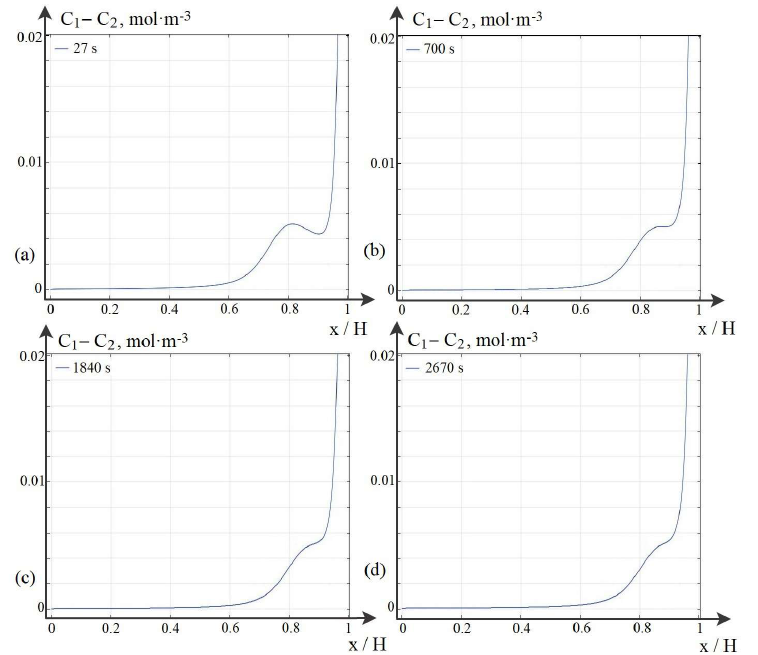
Figure 2. Dependence of the local maximum on the exchange capacity of the cation-exchange mem- brane (NaCl, ∆ r ϕ = 0.5) ( a ) C 1 m = 14, ( b ) C 1 m = 350, ( c ) C 1 m = 920, ( d ) C 1 m =